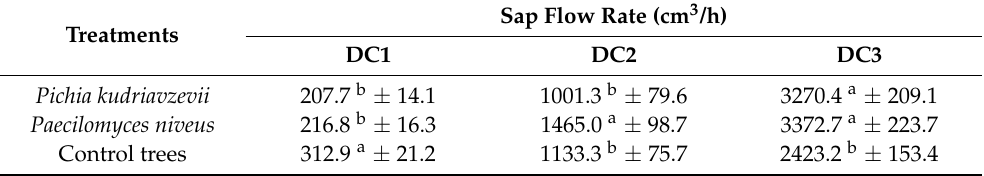
Table 5. Sap flow rates by treatment types at different diameter classes of A. malaccensis .